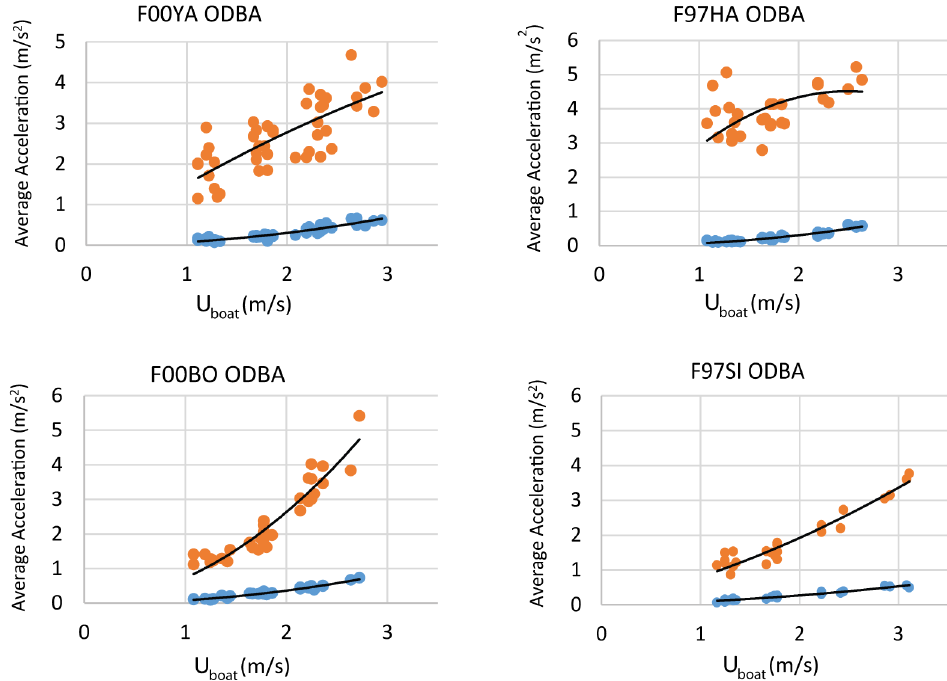
estimate the gain in speed per stroke. It also makes it possible to calculate stroke rates. Stroke rate can be also calculated only with acceleration data using running mean or low-pass filters, but Fig 4 suggests that the results will be less reliable (compare Fig 5c with 5d). We found a relatively weak correlation between stroke rates and swimming speed, which agrees with prior work by [18,32]. Feldkamp [18] noted that “ frequency can vary by 50% at a single velocity ” . Hindle et al. [32] found a negative correlation between ODBA/stroke and the stroke frequency at a given speed, suggesting that the animal can trade off stroke power for stroke frequency.